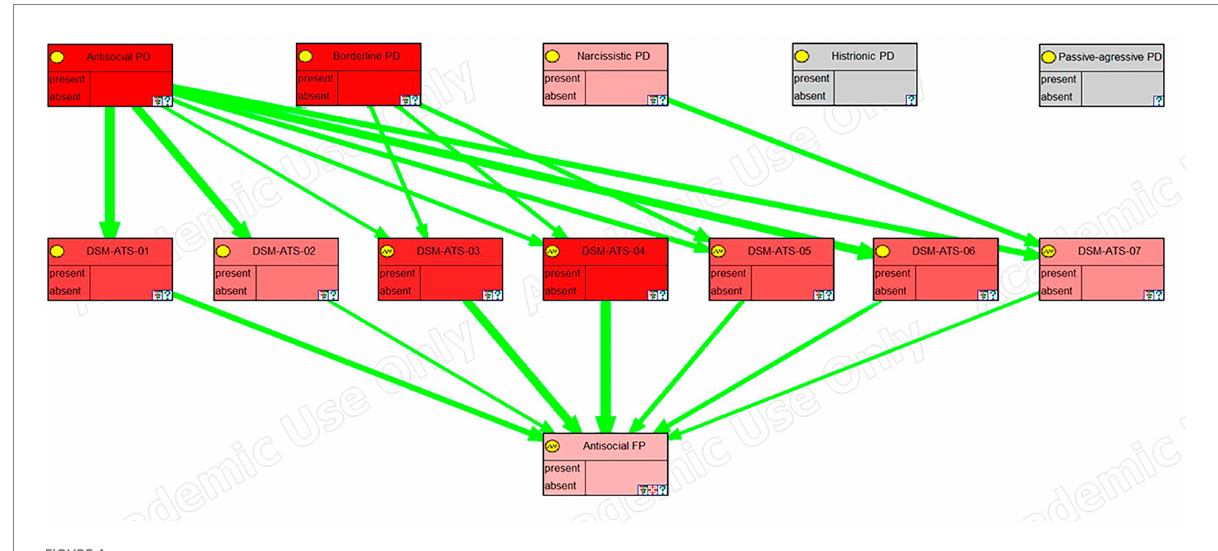
FIGURE 4 Sensitivity analysis, in GeNIE, for antisocial DSM